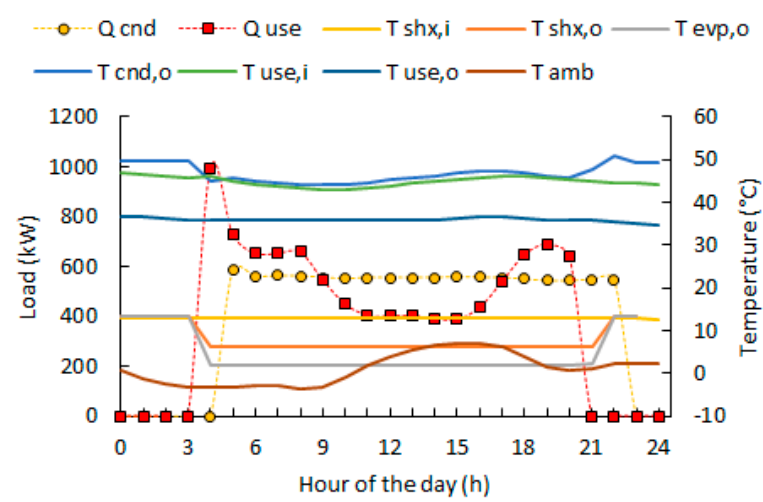
Figure 16. Transient operation in heating mode (fouled SHX). Energies 2019 , 12 , x FOR PEER REVIEW